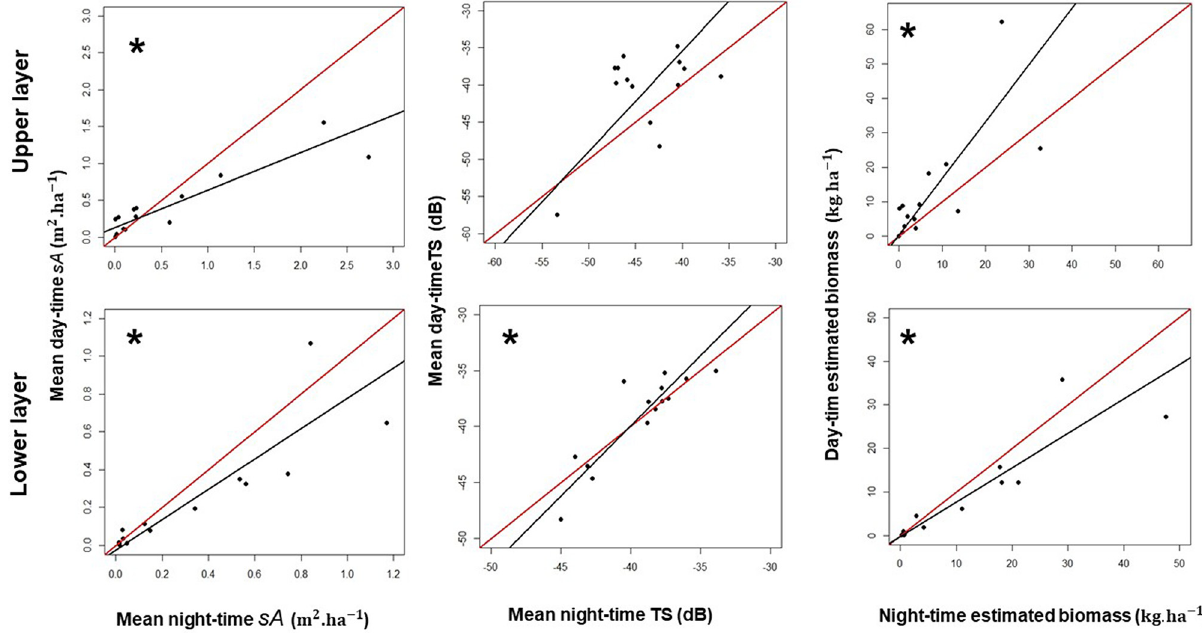
Fig. 2. Linear relationship between day and night results for upper (A) and lower (B) depth layers in 14 temperate lakes. A star indicates signi fi cant correlations ( p < 0.05). The red line represents the 1:1 line, and the black line the relationship estimated by the SMA ( N